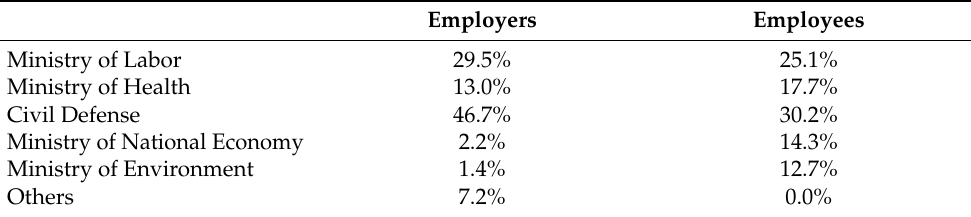
Table 4. Percentage of participating inspectors in the questionnaire from different official entities in charge of OSH inspection in Palestine.